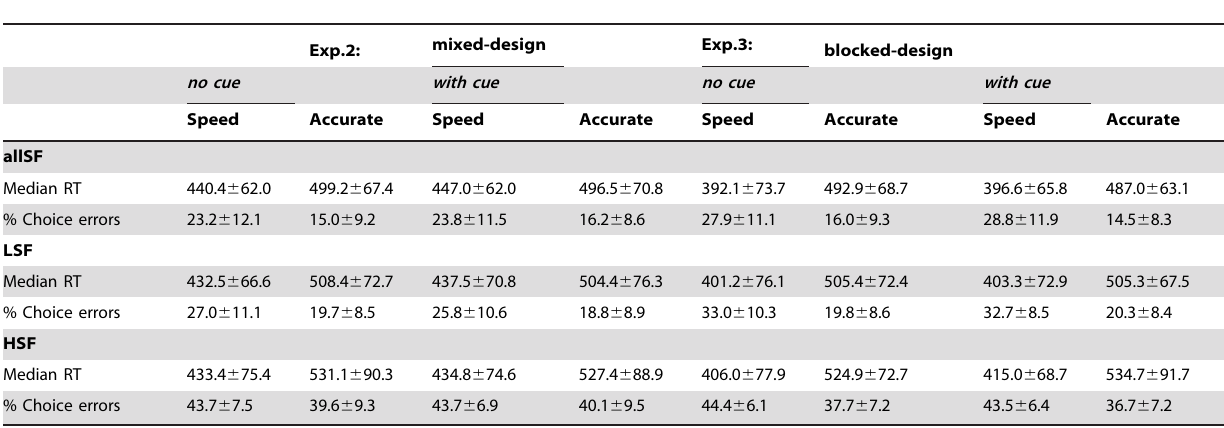
Table 3. Behavioral overview speed-accuracy